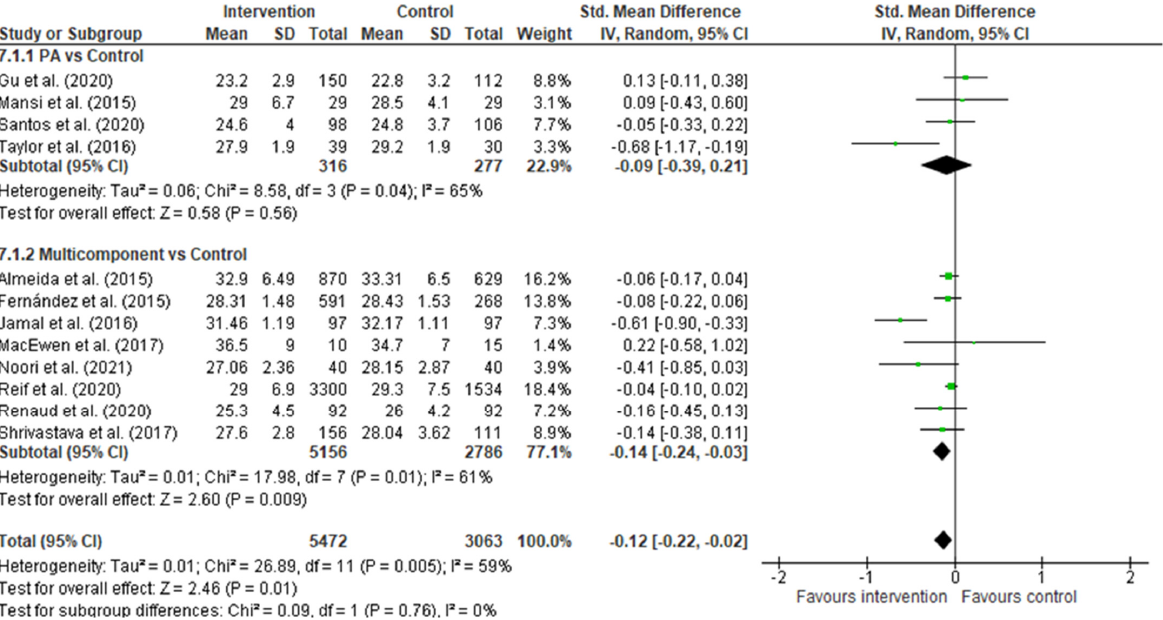
Figure 4. Forest Plot. Black diamond—Overall effect, 95% IC; Green box—study weight [24–35].